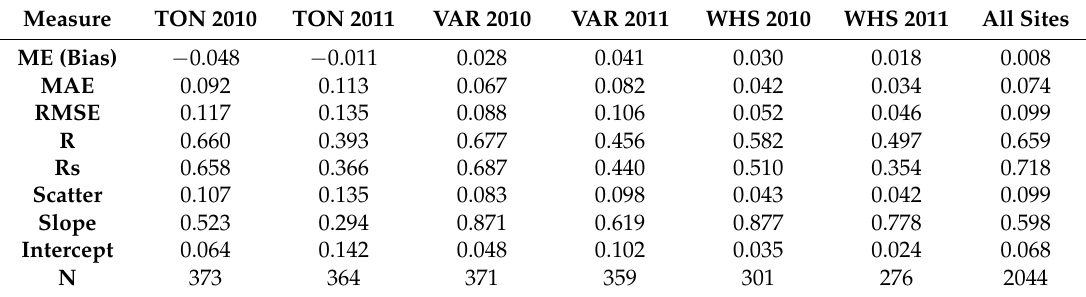
Table 4. Comparison between Satellite (ASCAT 25Km) and observed SSM at validation sites in the United States of America (USA), including all datasets for 2010 and